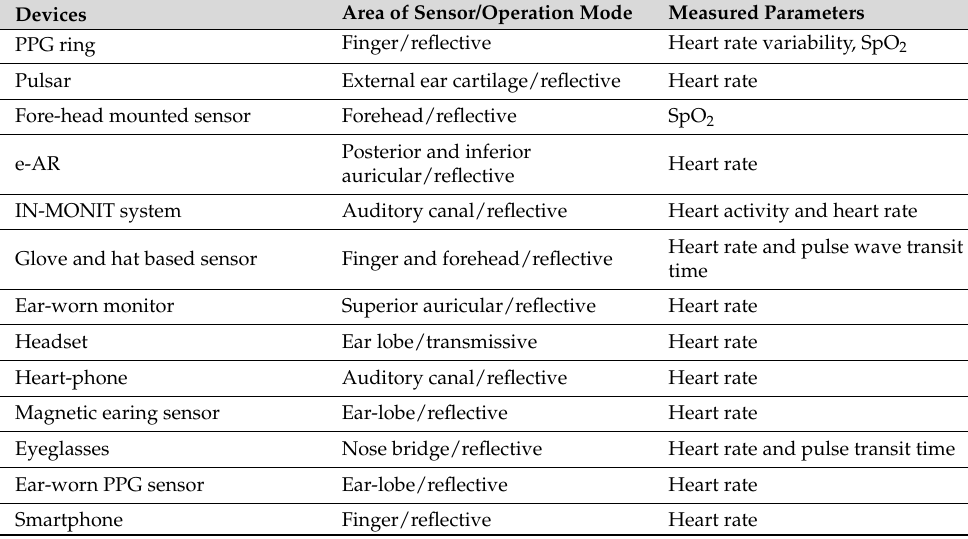
Table 2. PPG estimating gadgets at various destinations of the